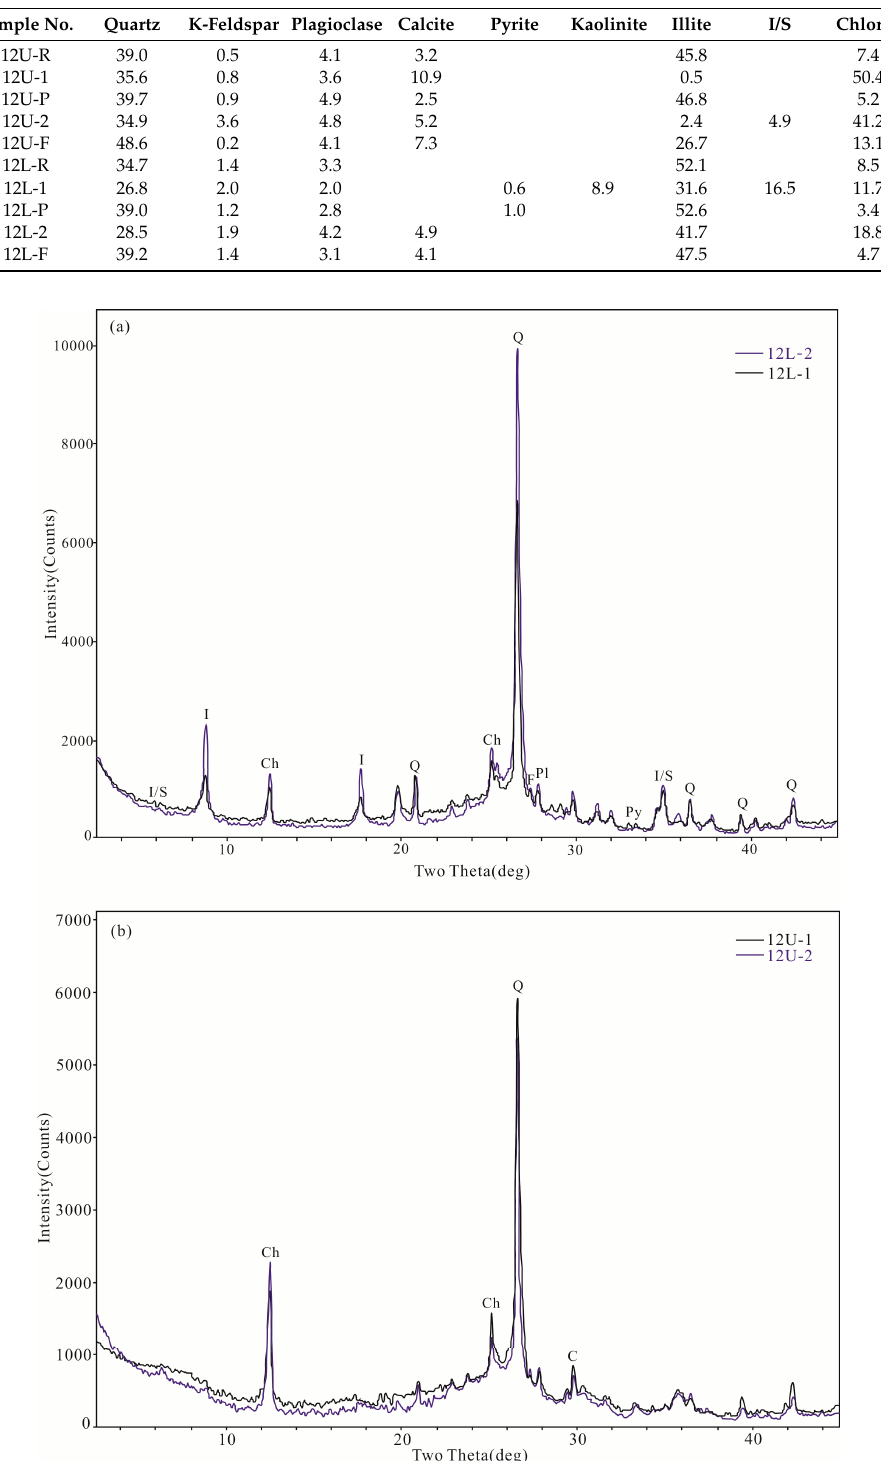
Figure 5. XRD patterns of 12L Coal ( a ) and 12U Coal ( b ). I = illite; Ch = chlorite; I/S = mixed-layer illite/smectite; Q = quartz; Pl = plagioclase; F = K-feldspar; C = calcite; Py = pyrite.